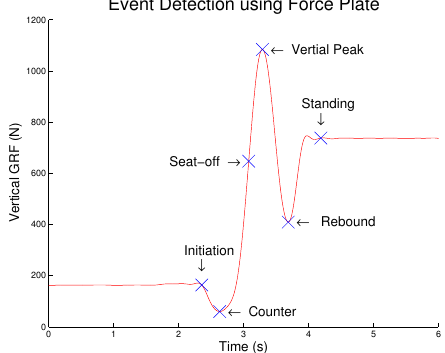
Figure 1: Force plate STS segmentation